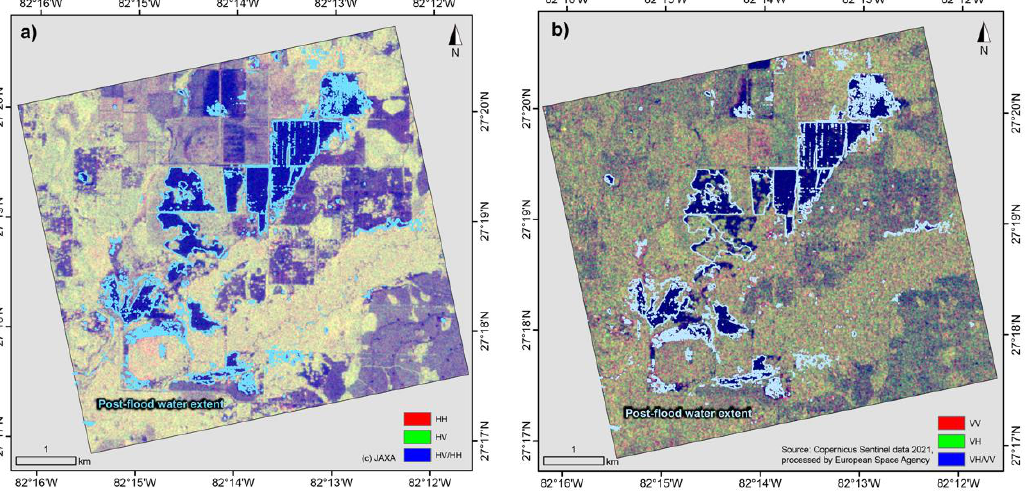
Figure 4. Post-flood amplitude imagery with RGB composite of dual polarization by ( a ) PALSAR-2 (12 September 2017) and ( b ) S1 (15 September 2015).